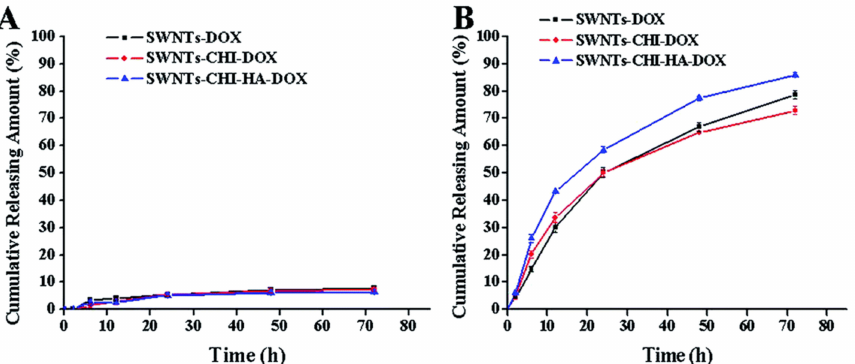
Figure 6. DOX release at 37 ◦ C in ( A ) pH 7.4 and ( B ) pH 5.5 PBS. Reprinted with permission from Ref. [8]. Copyright 2015 Royal Society of